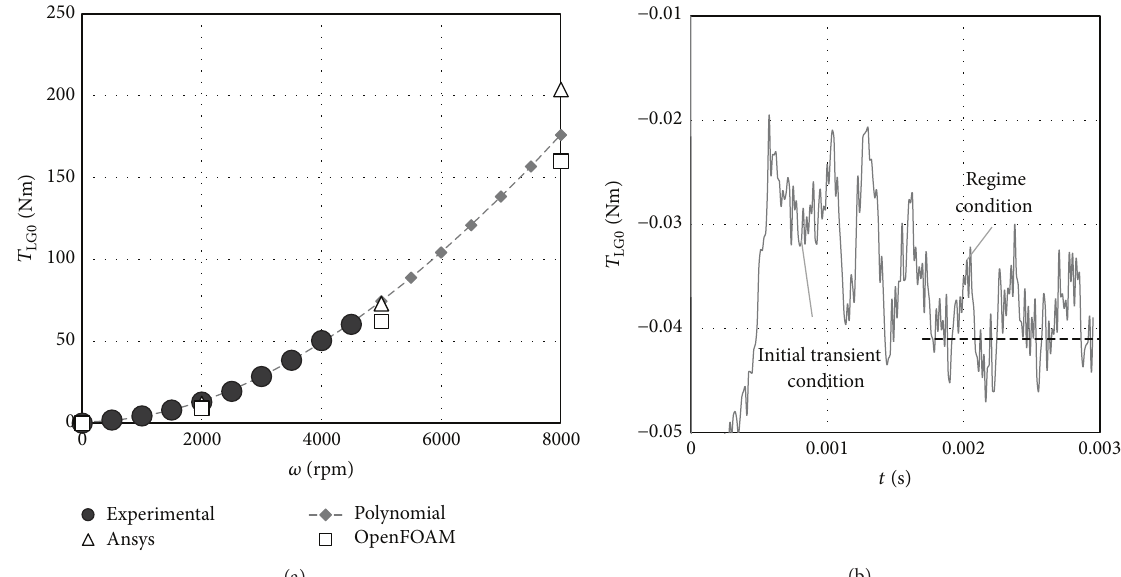
Figure 4: (a) Gear load independent resistant torque: experimental versus numerical data and (b) convergence monitor.